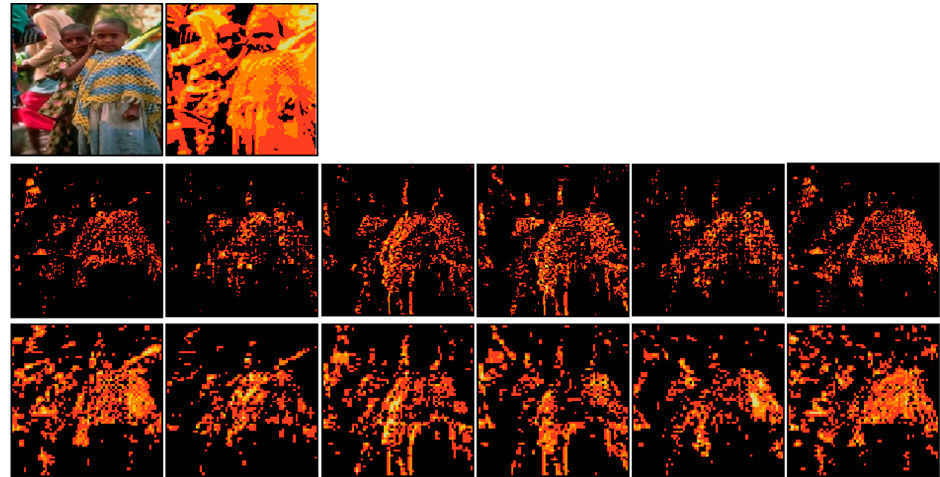
Figure 1. DTCWT features in two levels and six orientations (the complex sub-images are in the second and third rows, and the sample image and its two-level real image are listed in the first row).